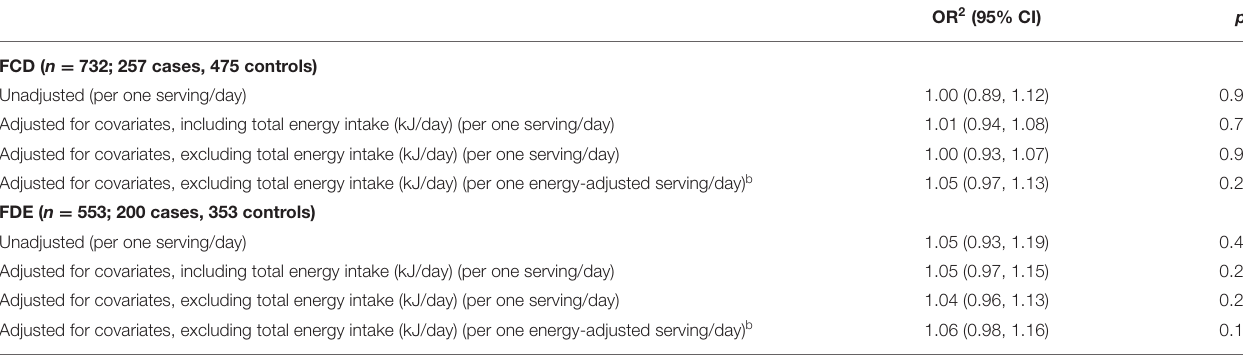
TABLE 2 | AIPW a models showing associations between the likelihood of FCD and FDE with total dairy consumption.